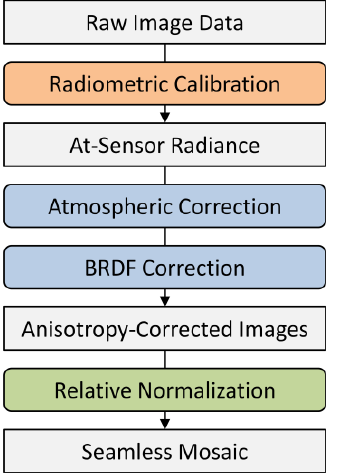
Figure 1. Radiometric correction work-flow for aerial images. There exists a number of BRDF and atmospheric models with different complexity, which can be empirical or physical. They well-known in our